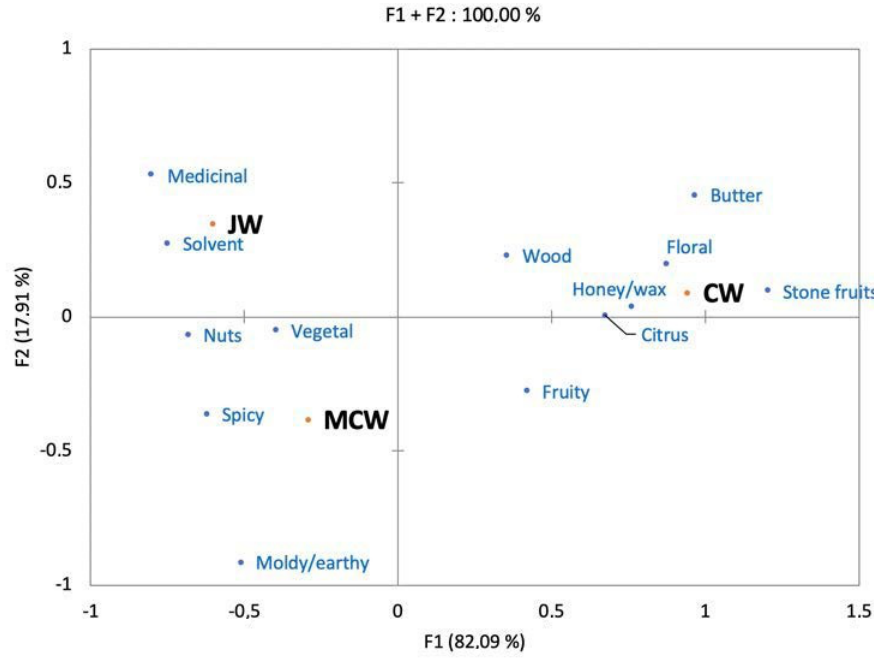
Figure 3. Correspondence analysis of the aroma description of the three wine samples.